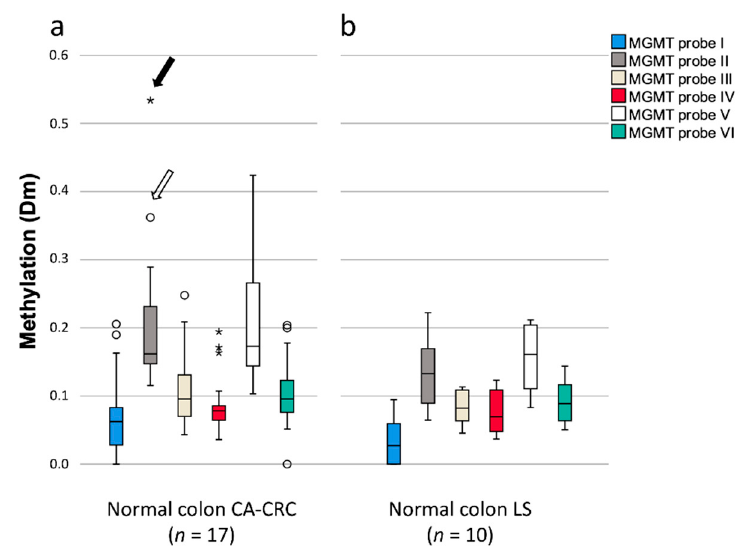
Figure 6. MGMT methylation in normal mucosa specimens. ( a ) Methylation degrees in normal colon of CA-CRC patients. ( b ) Methylation degrees in normal colon and LS patients. Arrows in Figure 6a denote cases discussed in the text, with higher Dm values in normal than tumor tissues. The upper and lower edges of the boxes are the 75th and 25th percentiles, the horizontal line inside the box indicates the median, the whiskers denote the highest and lowest values, and the asterisks and open circles represent outliers: extreme values and potential outliers, respectively (based on the interquartile range (IQR)).